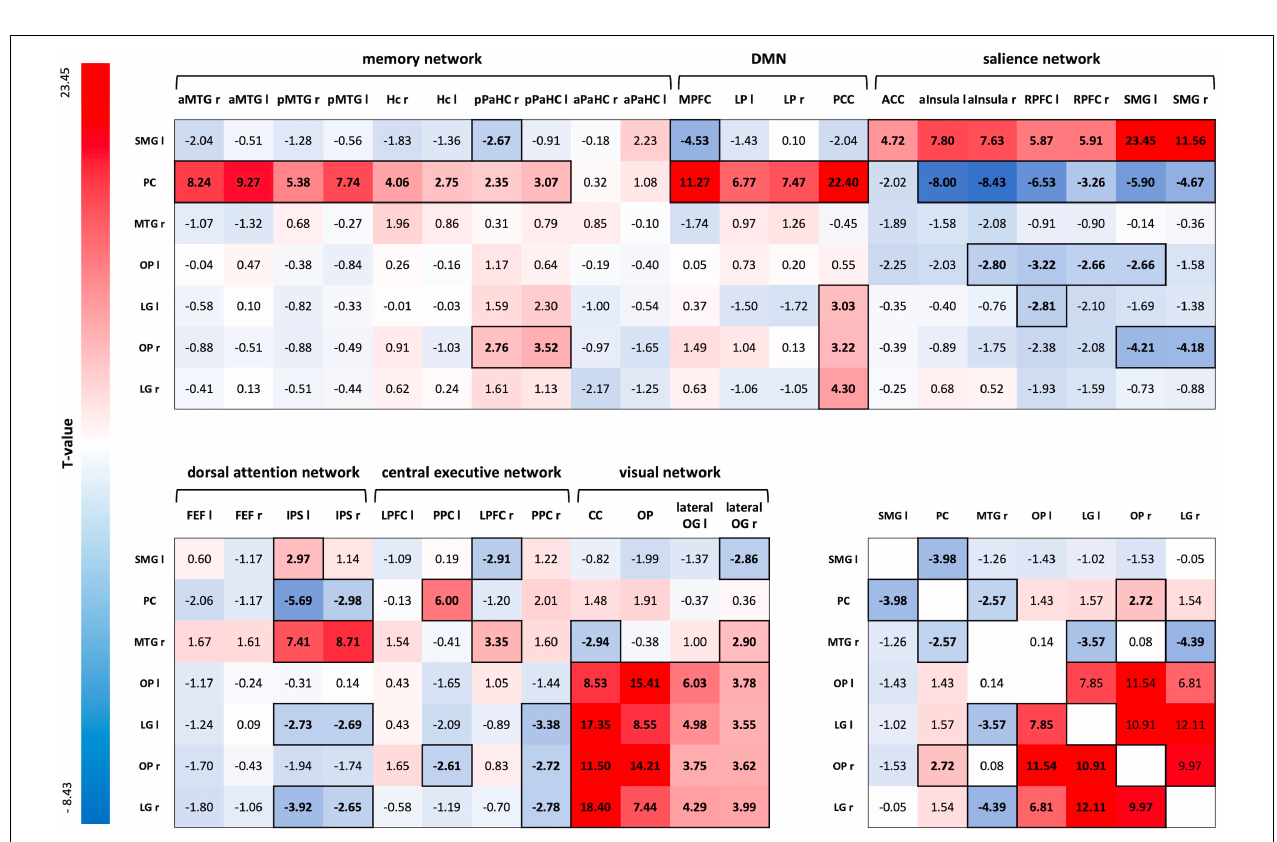
FIGURE 5 | ROI-to-ROI connectivity matrix for the R3 session of the control condition. T -values of one-sample t -tests of all ROI-to-ROI associations for delayed post-encoding rest (R3) of the control condition. Significant T -values are bold and outlined ( p-FDR < 0.05). Cells are colored red for positive coupling and blue for negative coupling between regions showing consolidation-related changes in resting-state activity (seed ROIs) and nodes of large-scale brain networks (target ROIs). SMG, supramarginal gyrus; PC, precuneus; MTG, middle temporal gyrus; OP, occipital pole; LG, lingual gyrus; aMTG, anterior MTG; pMTG, posterior MTG; Hc, hippocampus; pPaHC, posterior parahippocampal cortex; aPaHC, anterior parahippocampal cortex; MPFC, medial prefrontal cortex; LP, lateral parietal cortex; PCC, posterior cingulate cortex (including the Pc); ACC, anterior cingulate cortex; aInsula, anterior insula; RPFC, rostral prefrontal cortex; FEF, frontal eye field; IPS, inferior parietal cortex; LPFC, lateral prefrontal cortex; PPC, posterior parietal cortex; CC, calcarine cortex; lateral OG, lateral occipital gyrus; ROI, region of